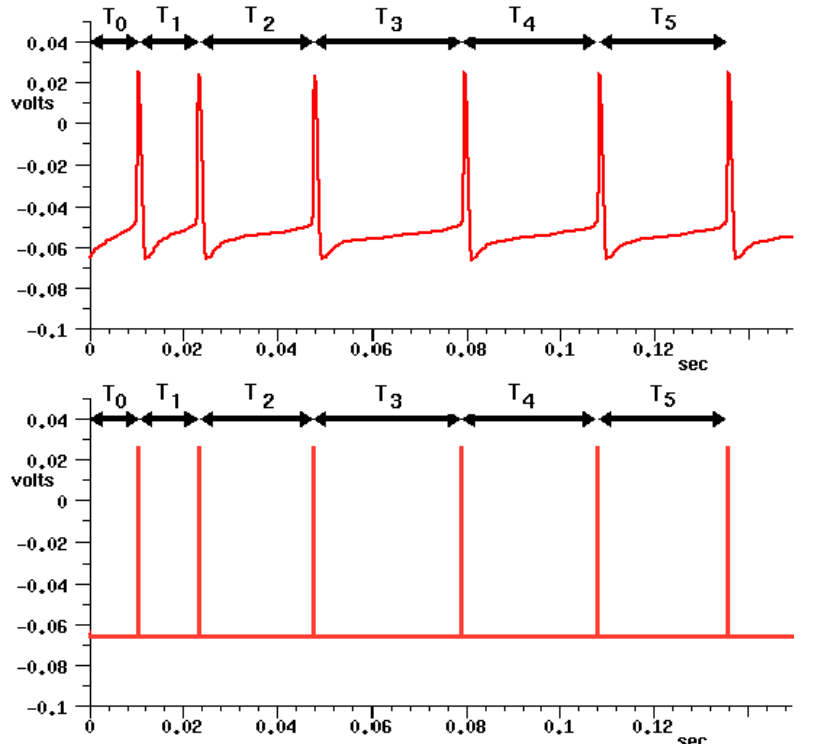
Figure 3. Representation of a neural pulse signal (above); and its electronic pulse equivalent (spike) PFM (below).